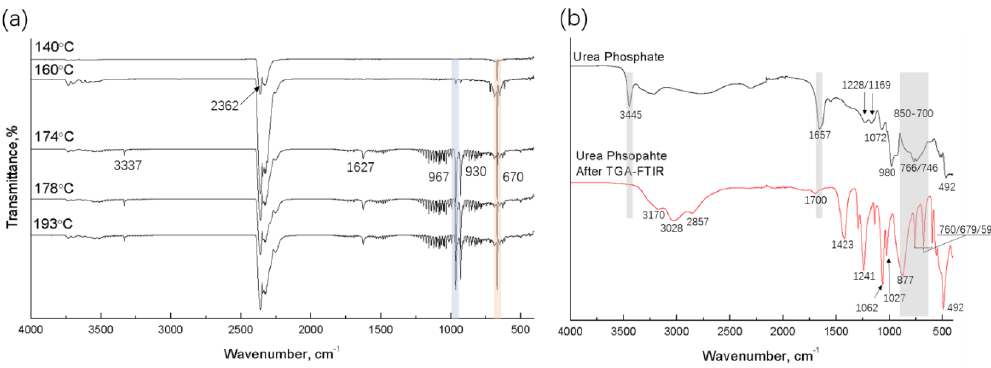
Figure 3. ( a ) FTIR spectra of UP off-gas during thermogravimetric analyzer (TGA) heating at different temperatures and ( b ) ATR-FTIR spectra of UP before and after TG-FTIR.